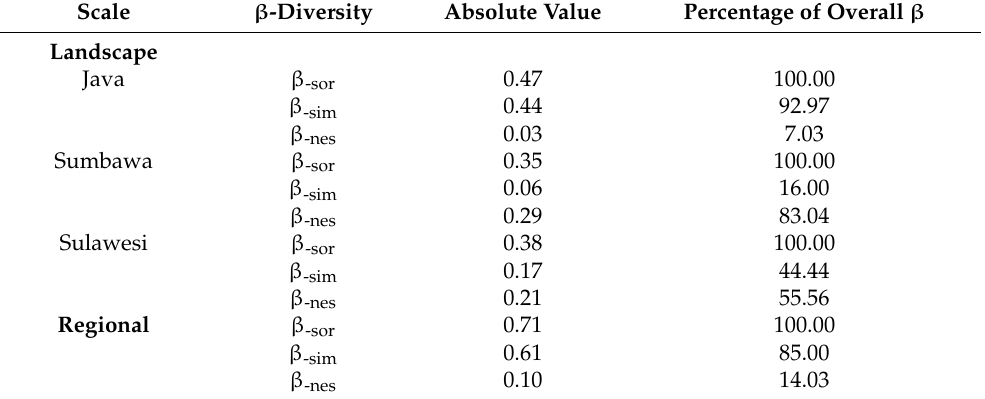
Table 5. Overall and beta diversity ( β ‐ sor ) partitioning in its spatial turnover ( β ‐ sim ) and nestedness ( β ‐ nes ) components based on multiple sites across the landscape (among sites within the island) and regional/island (among twelve sites) scale.